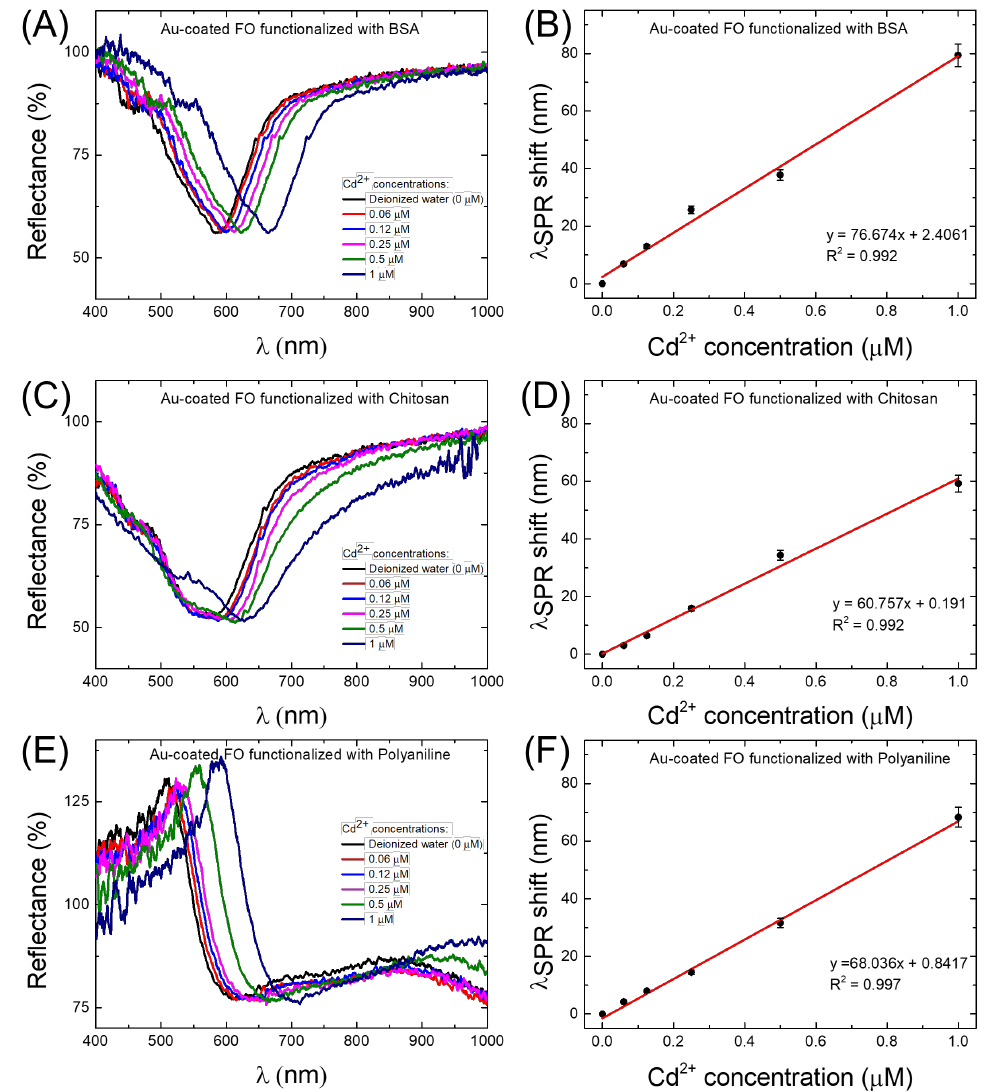
Figure 3. SPR spectra for varying concentrations from 0 to 1 µ M of Cd 2 + using ( A ) BSA, ( C ) chitosan, and ( E ) PANI/Au-coated FO-SPR sensors. ( B , D , F ) Corresponding calibration curves of the FO-SPR sensors. The error bars represent standard deviation ( n =